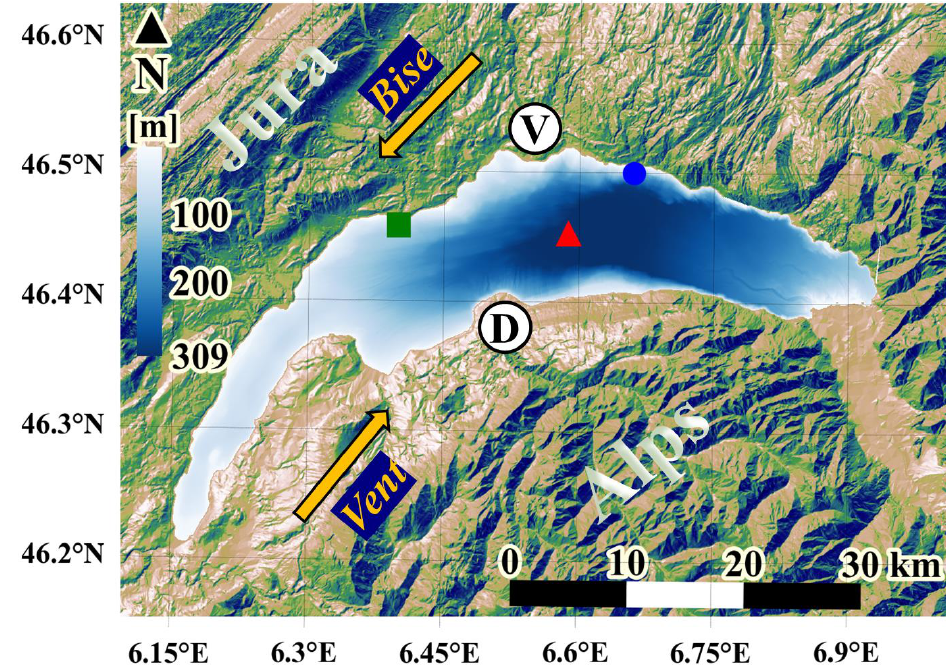
Figure 1. Lake Geneva and surrounding topography. Red triangle: location of the long-term CIPEL monitoring station SHL2 where physical and biological parameters are measured. Green square: EPFL Buchillon Mast meteorological station (100-m offshore). Blue circle: L é XPLORE floating platform. The thick yellow arrows indicate the direction of the two strong dominant winds, called the Bise (coming from the northeast) and the Vent (coming from the southwest). V and D are the deltas of the Venoge and the Dranse rivers, respectively. These markers will be used in the figures below as reference points. The color legend describes the depth of the lake.